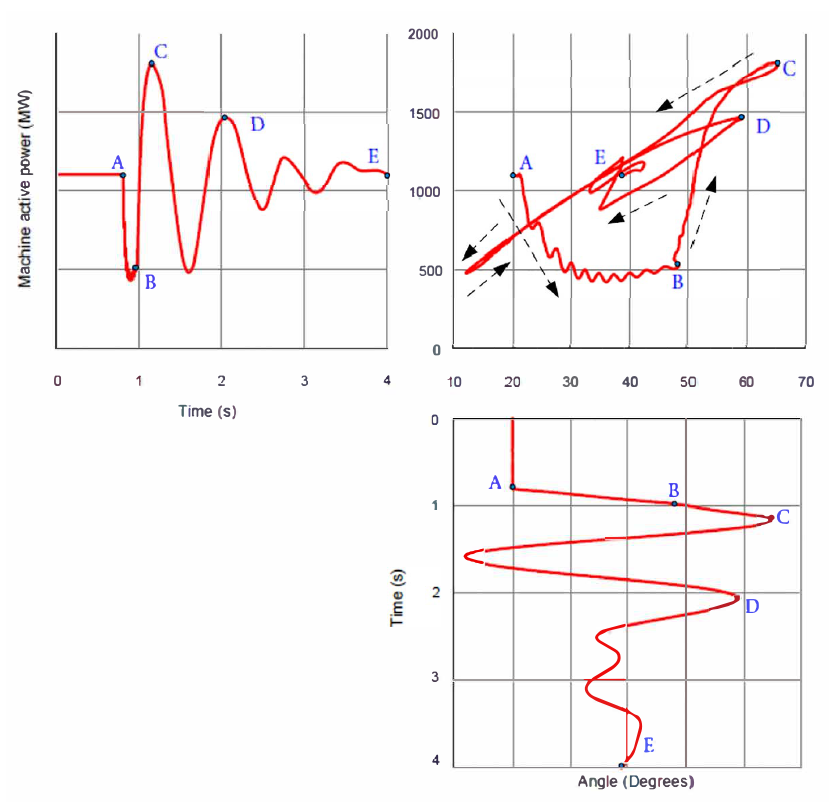
Figure 14. P- δ curve of the RTDS-based